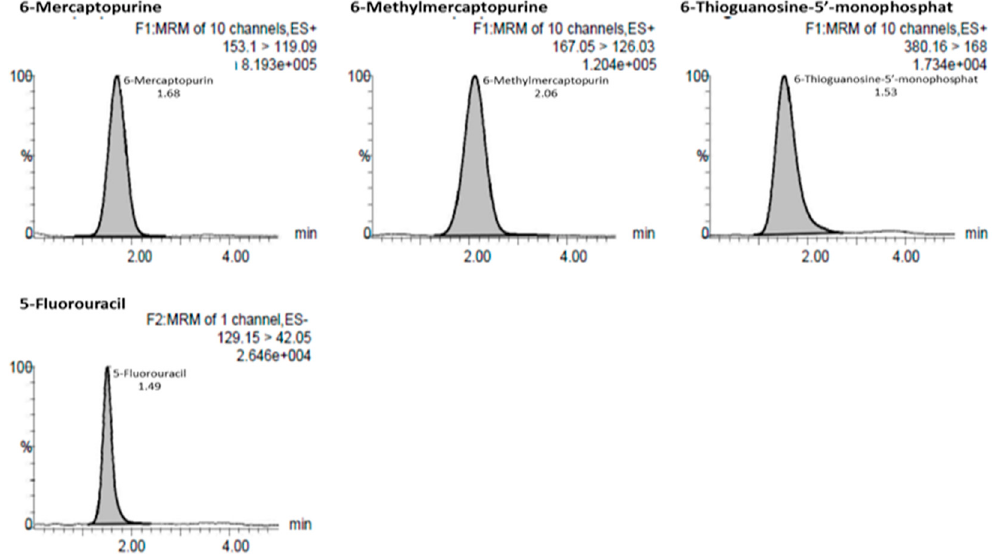
Figure 2. Chromatograms of 6-mercaptopurine, 6-methylmercaptopurine, 6-thioguanosine-5 ′ - monophosphate, and 5-fluorouracil.